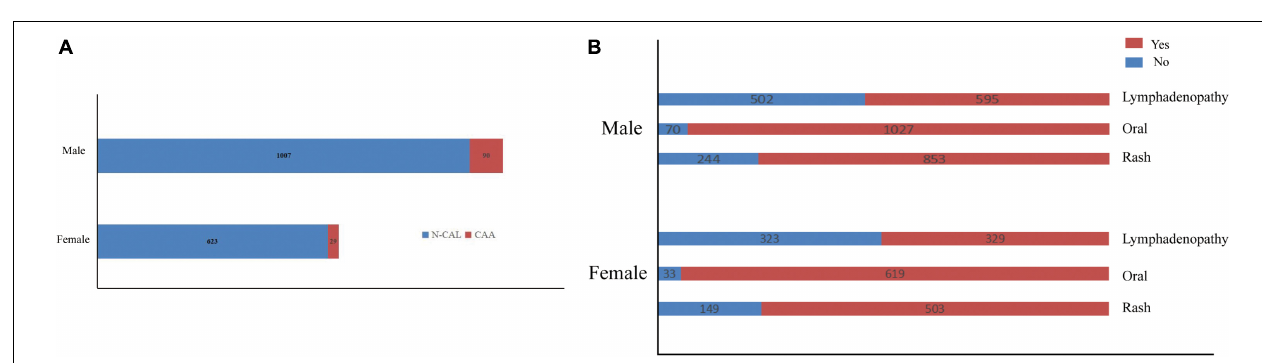
FIGURE 4 | The DCAs of three models for predicting CAA in the development cohort and the validation cohort.